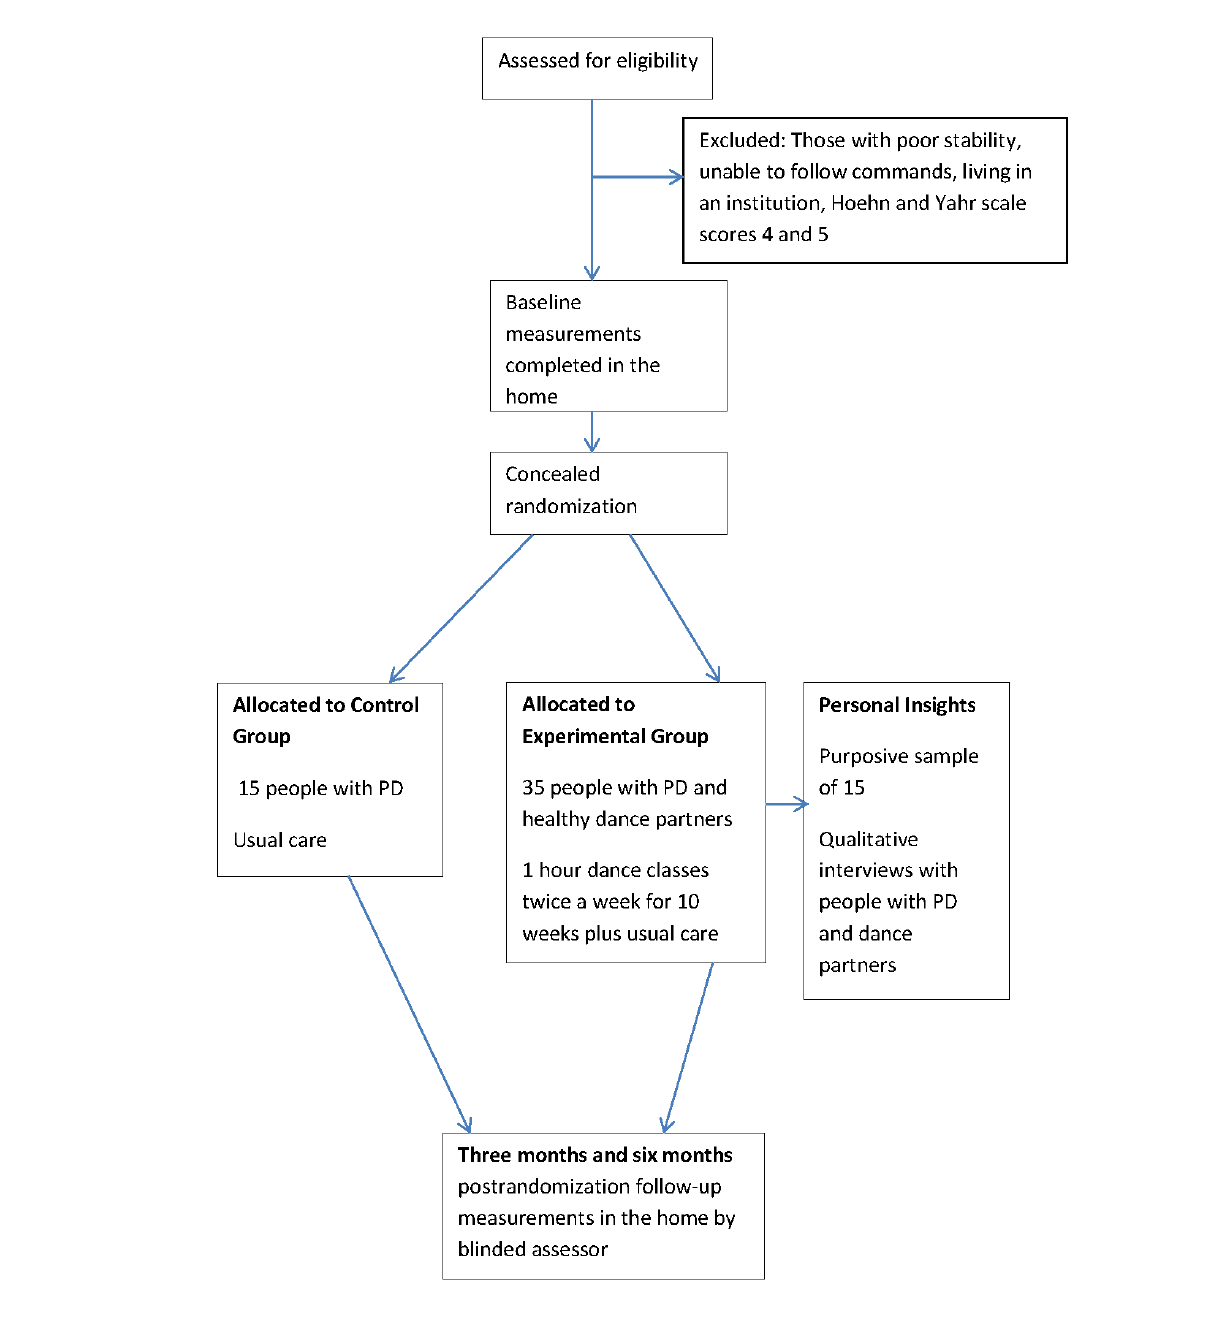
Figure 1. Flowchart of trial